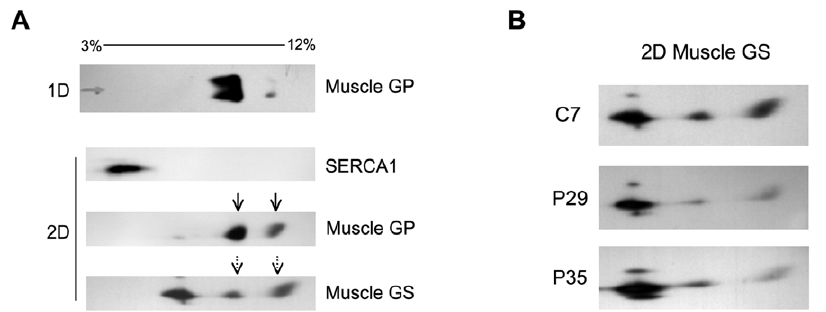
Figure 4. BN-PAGE of muscle GP, muscle GS, and SERCA1. A. BN-PAGE for control C4. In the first dimension (1D), acrylamide percentage ranges from 3% to 12%. In the second dimension (2D), continuous arrows indicate the 2 protein complexes in which muscle GP participates. Discontinuous arrows show muscle GS forming complexes with muscle GP. B. Second dimension of muscle GP BN-PAGE in a control (C7) and patients (P29 and P35).